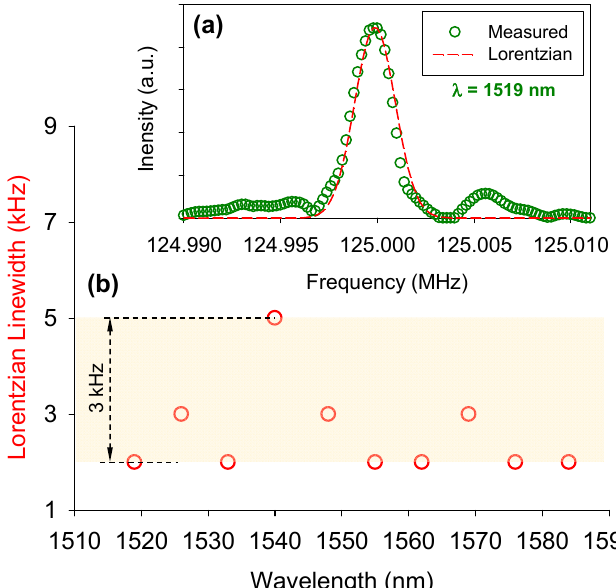
Figure 8. ( a ) The frequency spectra of measured data and Lorentzian fitting at 1519.0 nm wavelength. ( b ) Obtained Lorentzian linewidth over the tuning scope of 1519.0 to 1584.0 nm.